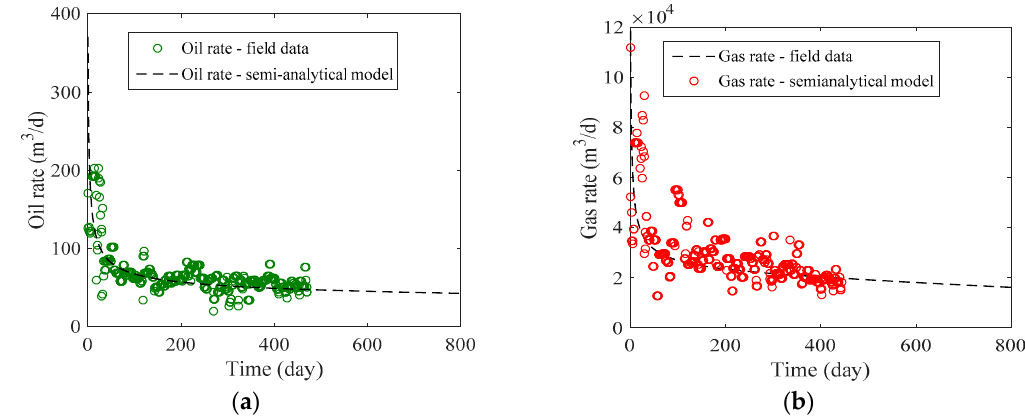
Figure 13. History matching results for field case: ( a ) Cartesian plot of oil production; ( b ) Cartesian